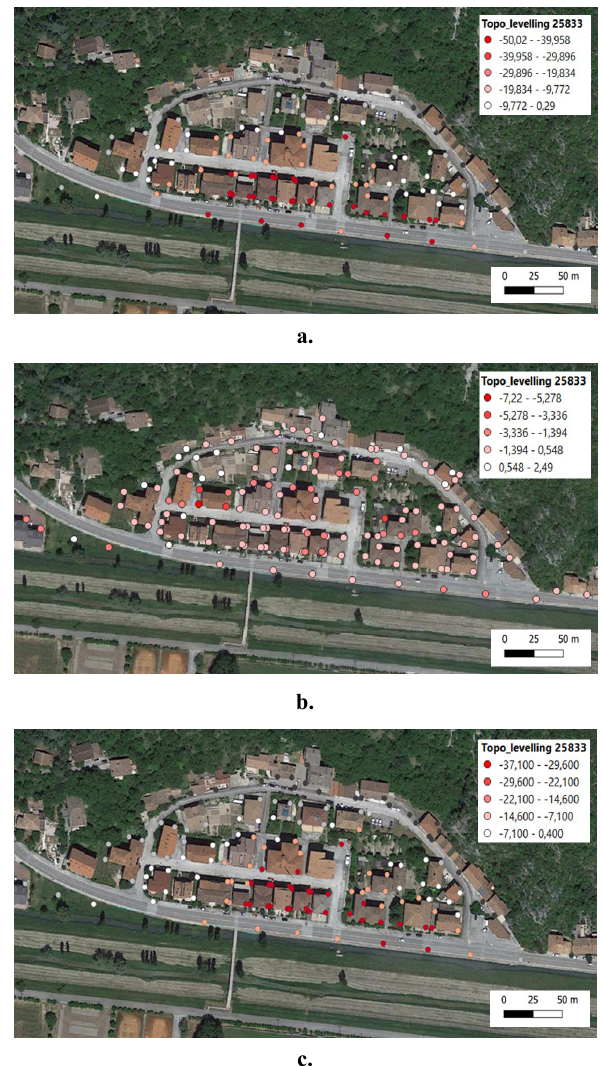
Figure 5. Ground displacements, expressed in millimetres, from topographic levelling: a. in the period 04/01/2012 to 28/09/2016 (earthquake on 24 th of August 2016) b. in the period 28/09/2016 to 05/11/2016 (earthquakes on 26 th and 30 th of October 2016) c. in the period 13/02/2017 to 29/01/2021 (earthquake on 18 th of January 2017).